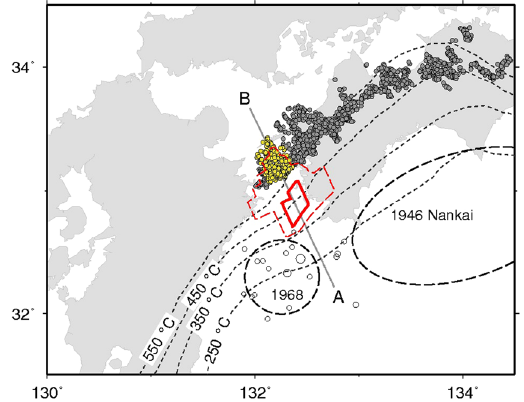
Figure 3. Red polygon with the solid and dashed lines shows the 2010 L-SSE with more than 0.2 m and 0.1 m slip areas estimated in this study. Yellow and grey circles indicate deep tremors detected during the 2010 L-SSE data period (2009.5 to 2011.2) using the modified envelope correlation method considering tremor amplitude 34 and the hybrid-clustering method 35 of the National Research Institute for Earth Science and Disaster Prevention (NIED) of Japan. Open ellipses with dashed lines indicate approximate source areas of the 1946 Nankai and 1968 Hyuga-nada earthquakes. Open circles represent hypocentres of earthquakes M > 3.0 and depth < 70 km from 1 April to 1 May 1968 as determined by JMA (Same as Fig. 1). Dashed contours show the temperature (250–550 °C) on the Philippine Sea plate 9 . The map is created by Generic Mapping Tools software (GMT